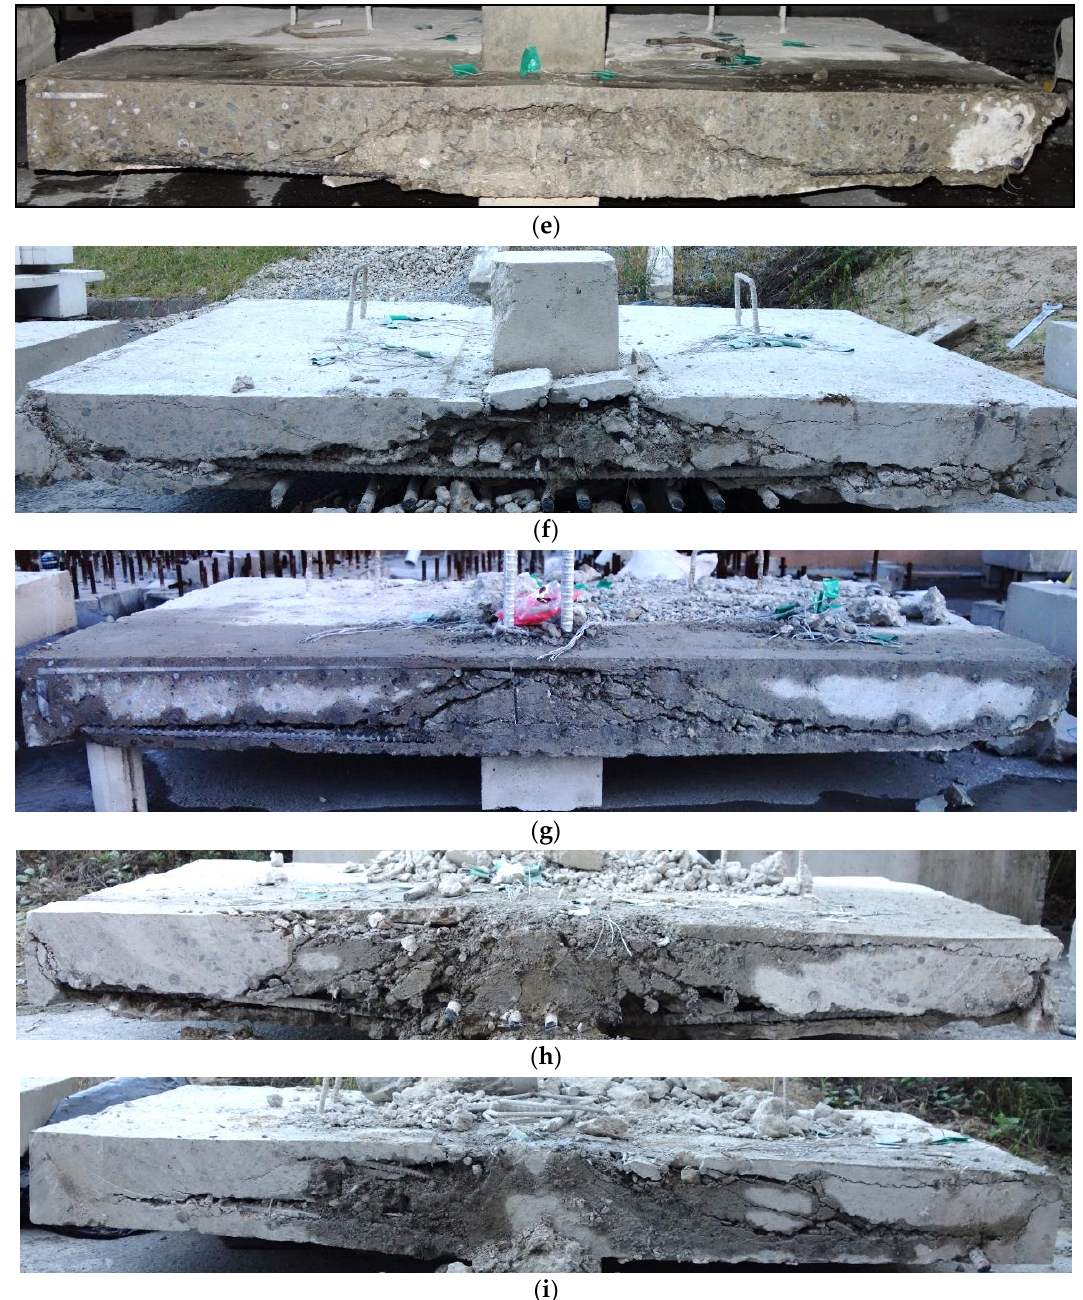
Figure 7. Crack patterns in the cut section: ( a ) Control; ( b ) G-184B; ( c ) G-184C; ( d ) G-246A; ( e ) G-246B; ( f ) G-246C; ( g ) G-307A; ( h ) G-307B; ( i ) G-369B.